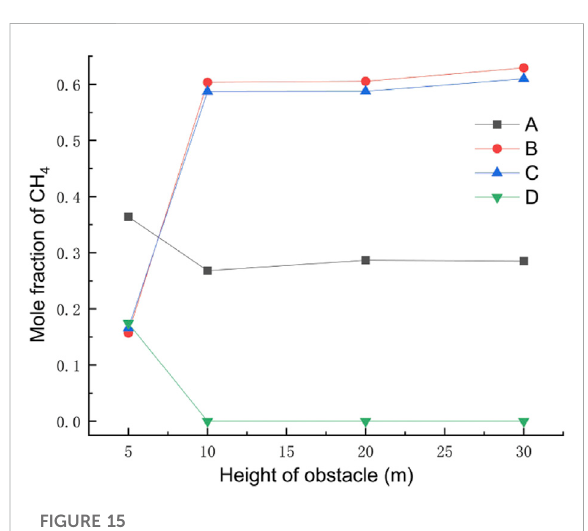
FIGURE 16 Diffusion height diagram for each obstacle height at different